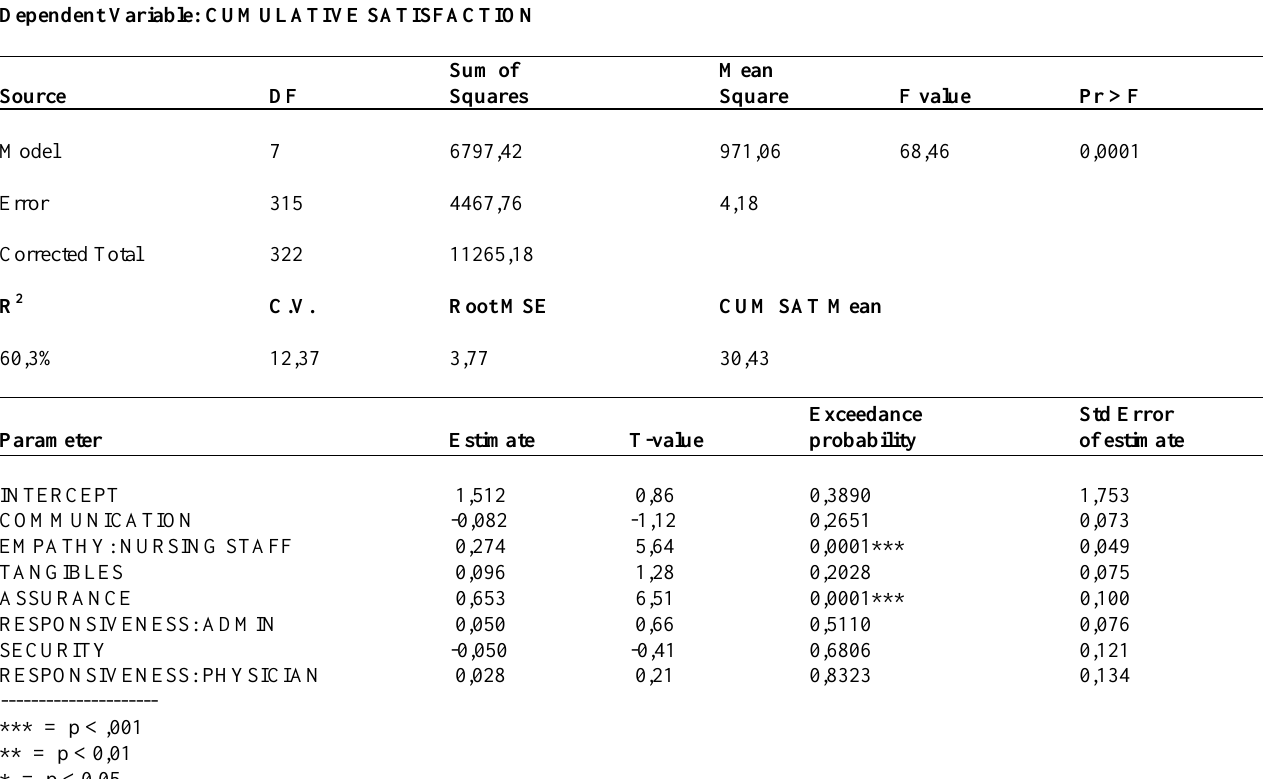
Table 4: Multiple regression results: Impact of service quality dimensions on cumulative